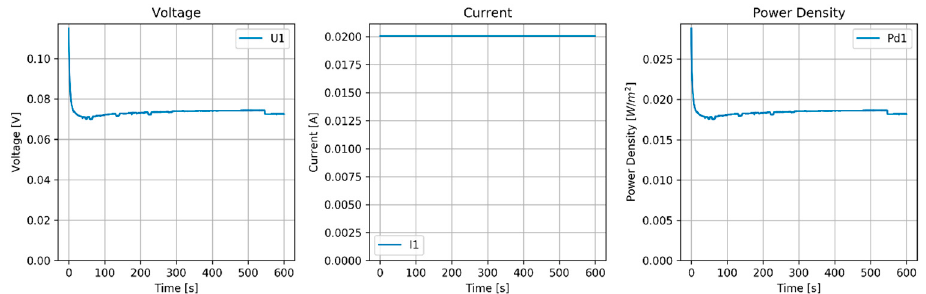
Figure 7. Results of the constant current (20 mA) test of the RED stack equipped with normal AEMs (AMX) and pseudo CEMs (Zn).